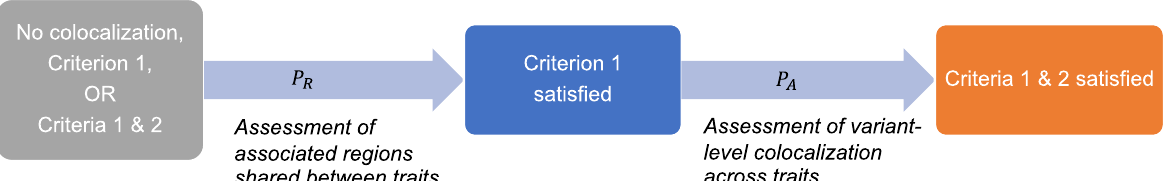
Fig. 2 Illustration of the HyPrColoc approximation. We illustrate the HyPrColoc approach with m = 2 traits. Statistical colocalization between traits which do not share an association region, i.e. do not have shared genetic predictors, is not possible (no colocalization criteria satis fi ed). However, traits which do (satisfying criterion 1) possess the possibility. HyPrColoc fi rst assesses evidence supporting all m traits sharing an association region, which quickly identi fi es utility in a colocalization framework. HyPrColoc then assesses whether any shared association region is due to colocalization between the traits (criteria 1 and 2) or due to a region of strong LD between two distinct causal variants, one for each trait (criterion 1 only). Results from these two calculations are combined to accurately approximate the PPFC